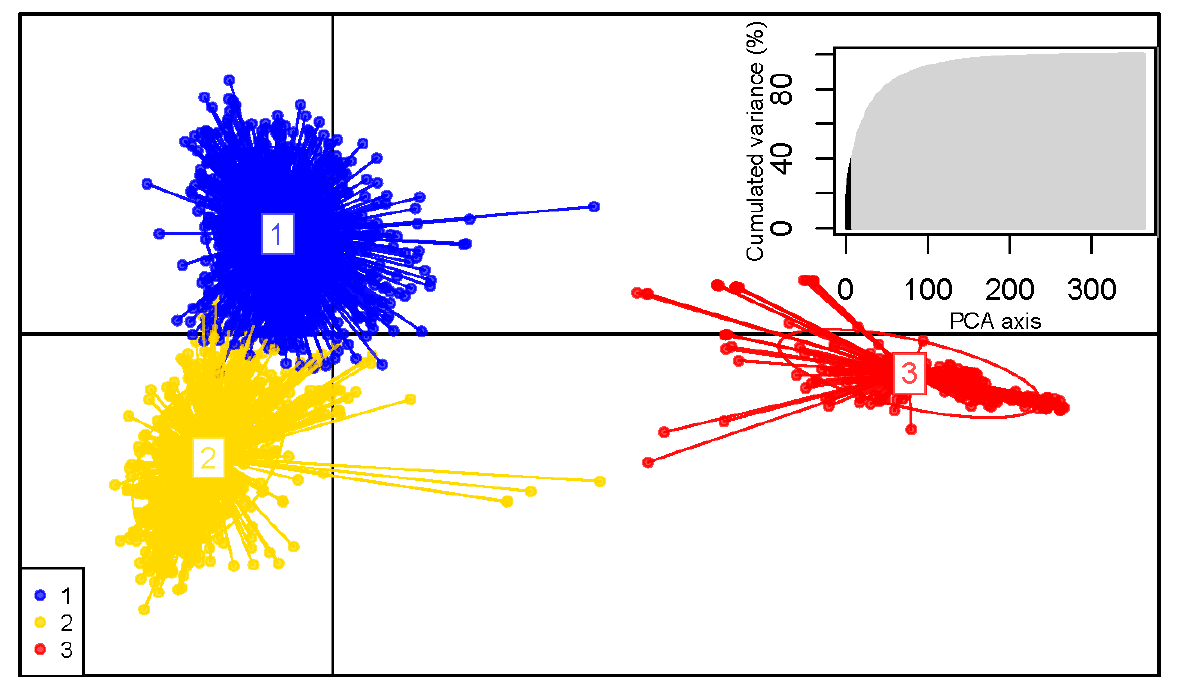
Figure 2. Bayesian clustering of D. septosporum multilocus haplotypes inferred using the program STRUCTURE at K = 3, K = 4 and K = 5. Each multilocus haplotype is represented by a vertical line partitioned into colored sections that represent the isolate’s estimated membership fractions in each cluster. Black lines separate isolates from different population groups.